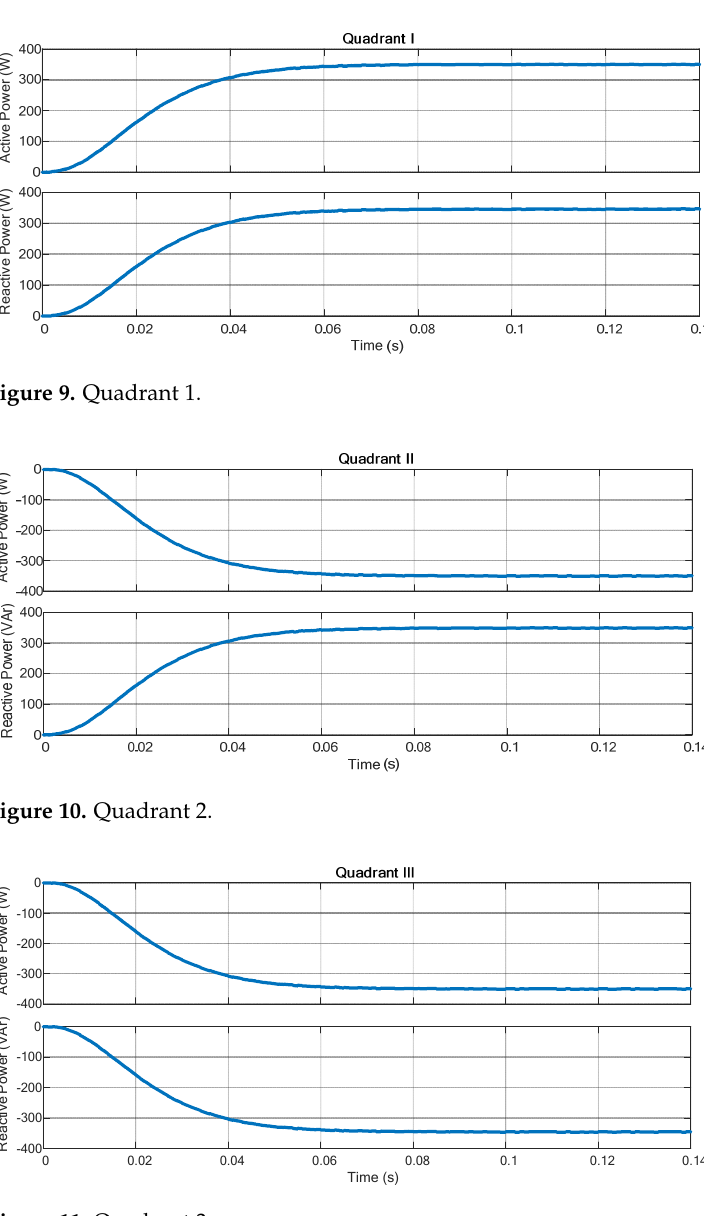
Figure 11. Quadrant 3.